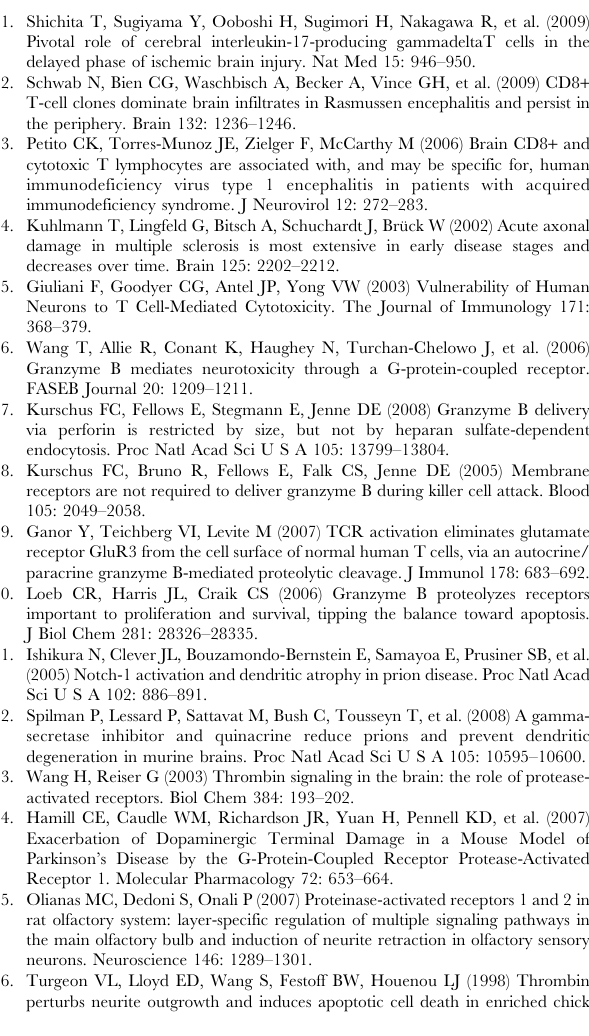
Figure S3 Activated T cells supernatant increased Kv1.3 expression in primary cultured human fetal neurons. Primary cultured human fetal neurons were treated with supernatants (1:20 dilution) from CD3/CD28 activated T cells (AT) or non-activated T cells (CT) for 18 hours. Neurotoxicity and the Kv1.3 expression were detected by immunostaining. AT treatment caused retraction of neuronal processes as evidenced by decreased b -III-tubulin staining but increased Kv1.3 expression in the damaged neurons. Figure S4 Detection of K + concentration using PBFI assay. The PBFI assay was calibrated with known extracellular K + concentrations which were increased from 0 to 160 mM in 40- mM increments by substituting Na + for K + in non-K solution. We found that the fluorescence values detected at Ex wavelength 340 nm correlated with the extracellular K +